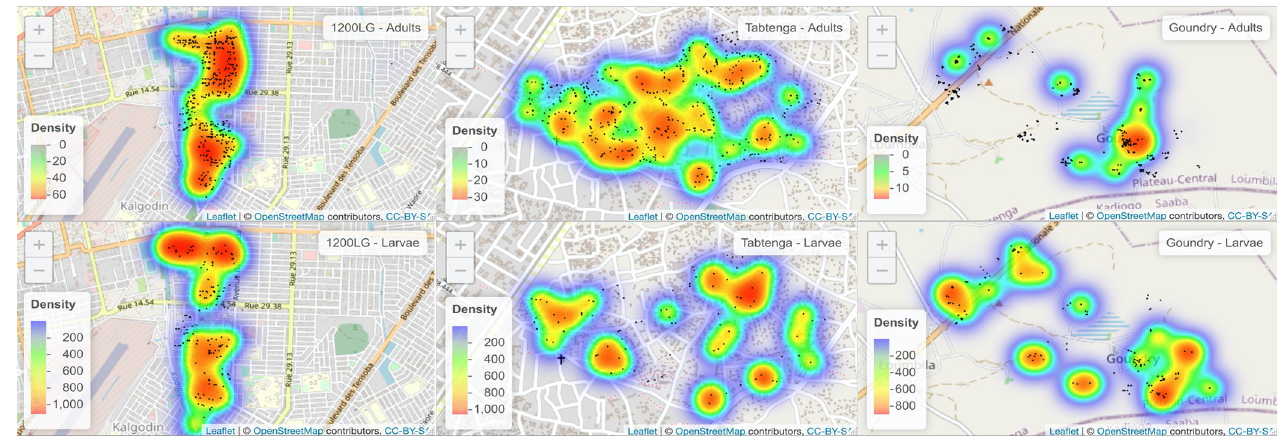
Fig 4. Density maps of Aedes aegypti adult (top) and larval (down) densities per house in Goundry (left), Tabtenga (middle) and 1200LG (right). The dark black spots represent the houses that were sampled. The base map was downloaded from https://rstudio.github.io/leaflet/., which follows the terms of use in